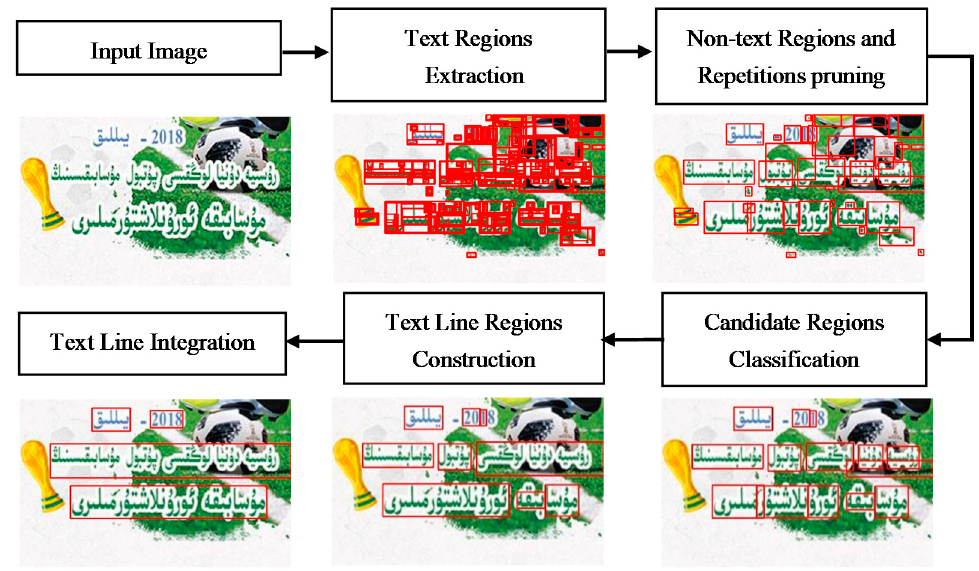
Figure 2. Flowchart of the proposed method and corresponding results of each step.